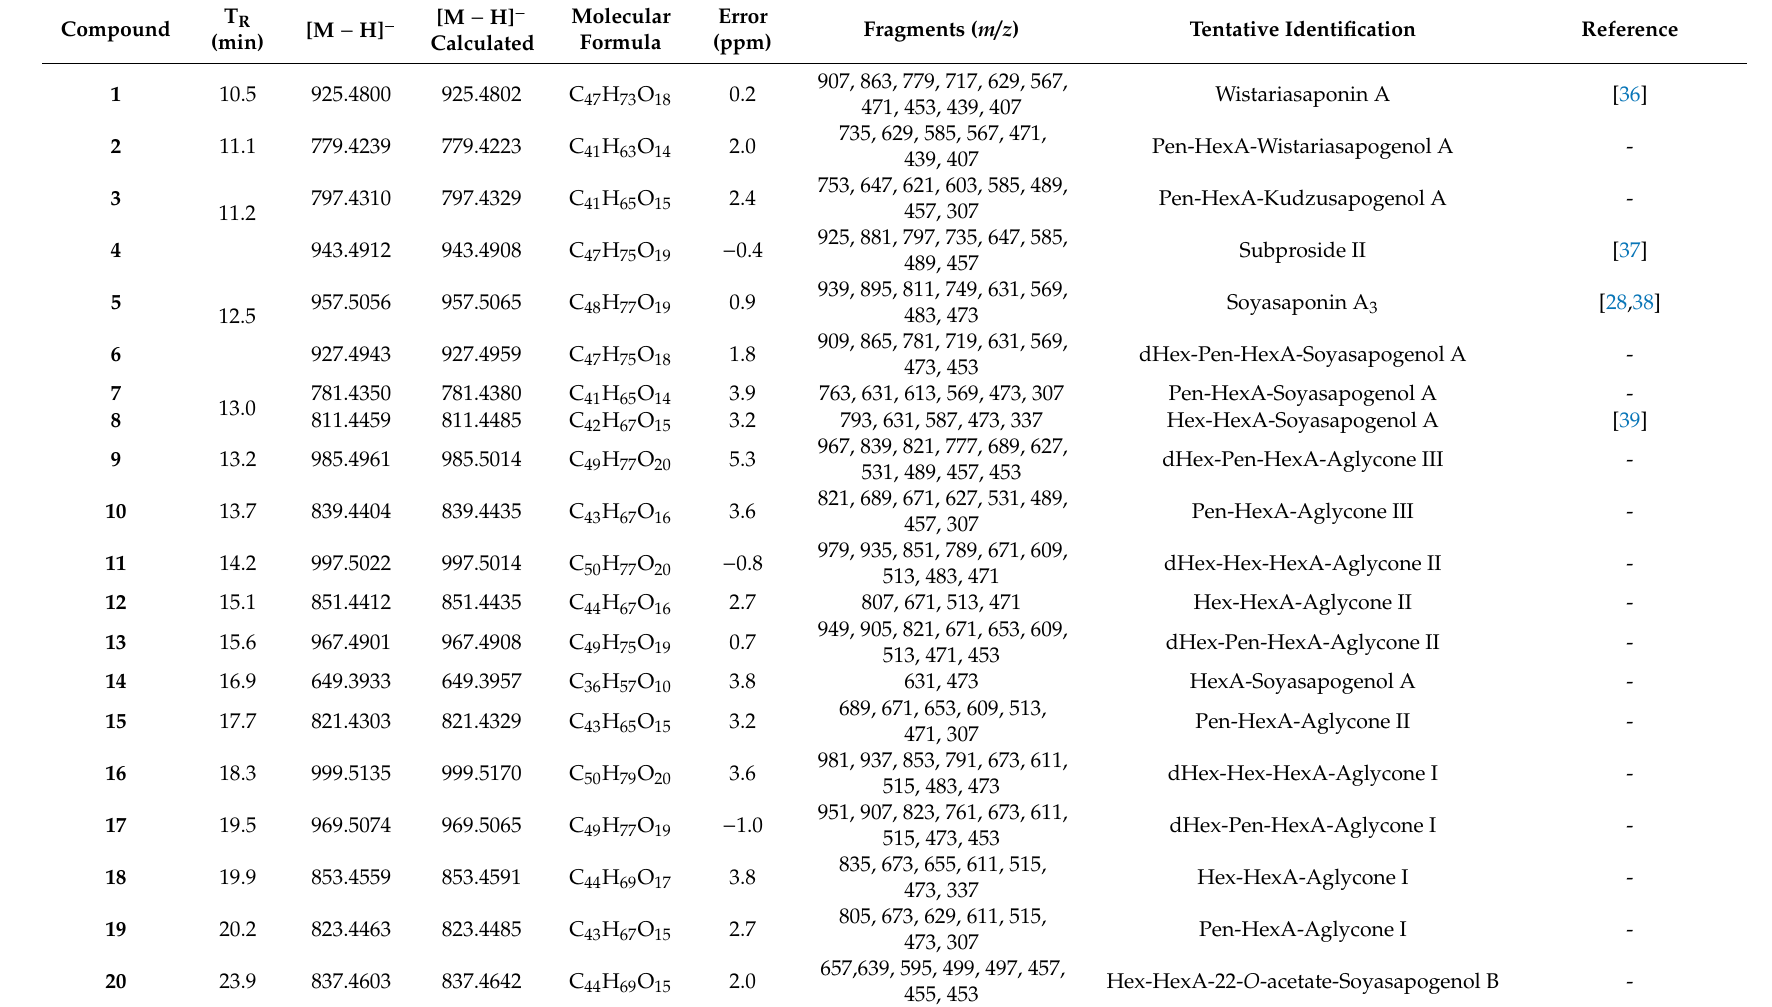
Table 1. Characterization of the saponins tentatively identified by HPLC-ESI-MS / MS in Z.